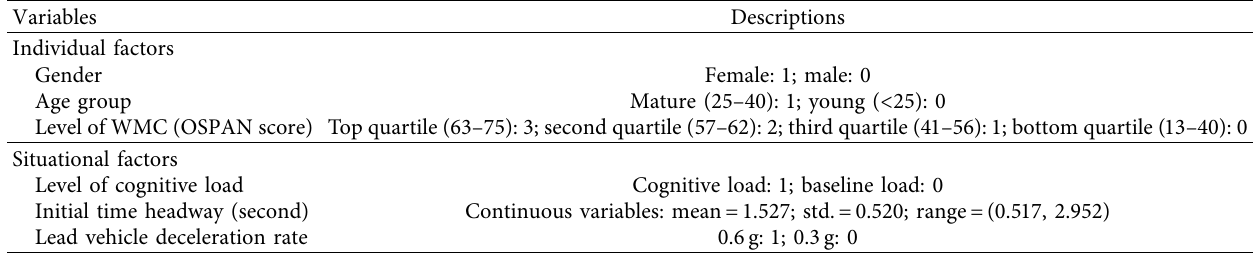
Figure 3: Effects of cognitive load, initial time headway, and lead vehicle deceleration rate. (a) Level of cognitive load. (b) Initial time headway. (c) Lead vehicle deceleration Table 1: Definition of independent variables.